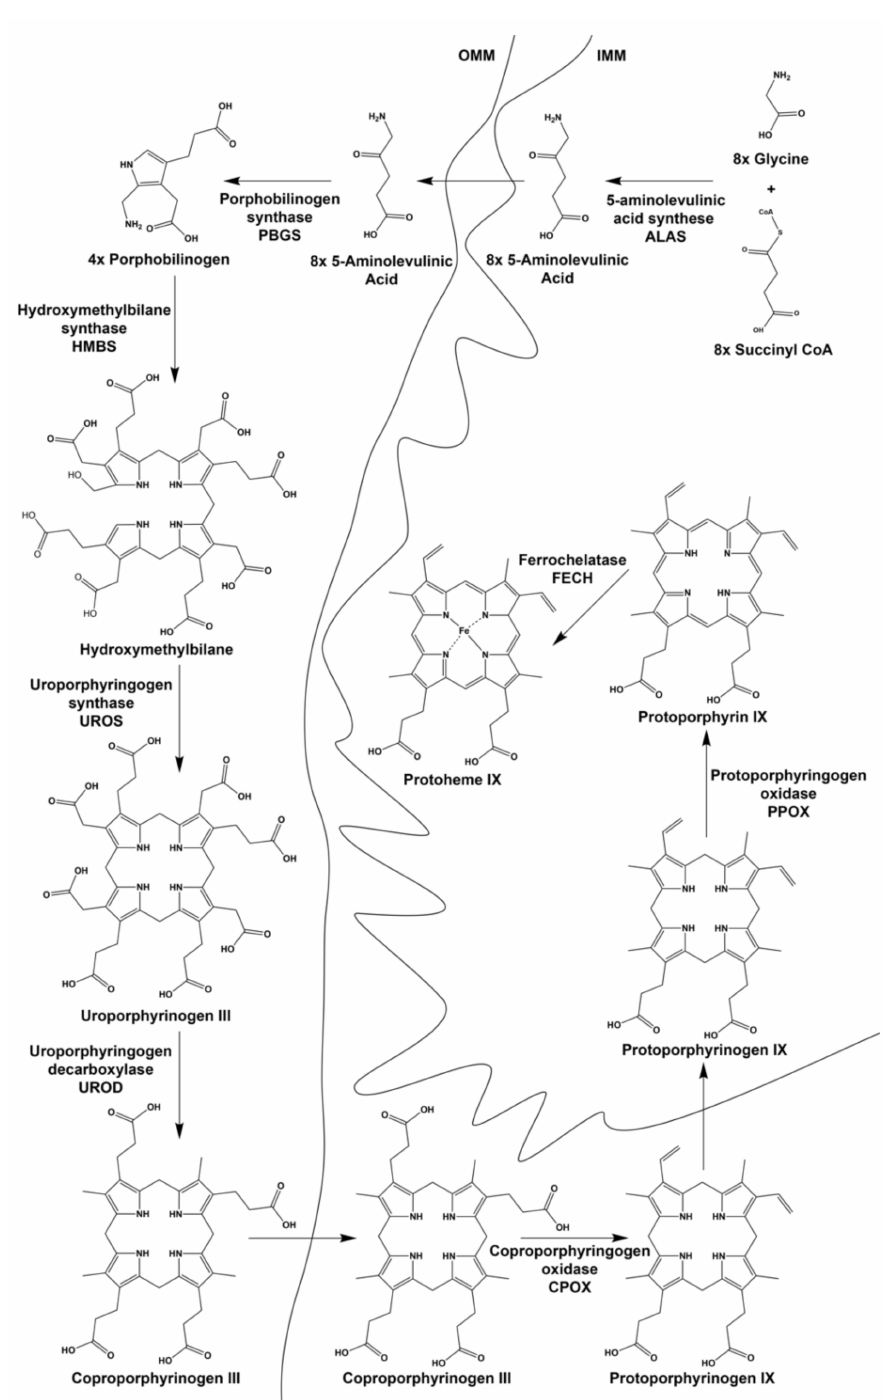
Figure 2. Intermediates and enzymes of the heme biosynthetic pathway. Both intermediates and enzymes are shown as well as their cellular localization. OMM is the outer mitochondrial membrane and IMM is the inner mitochondrial